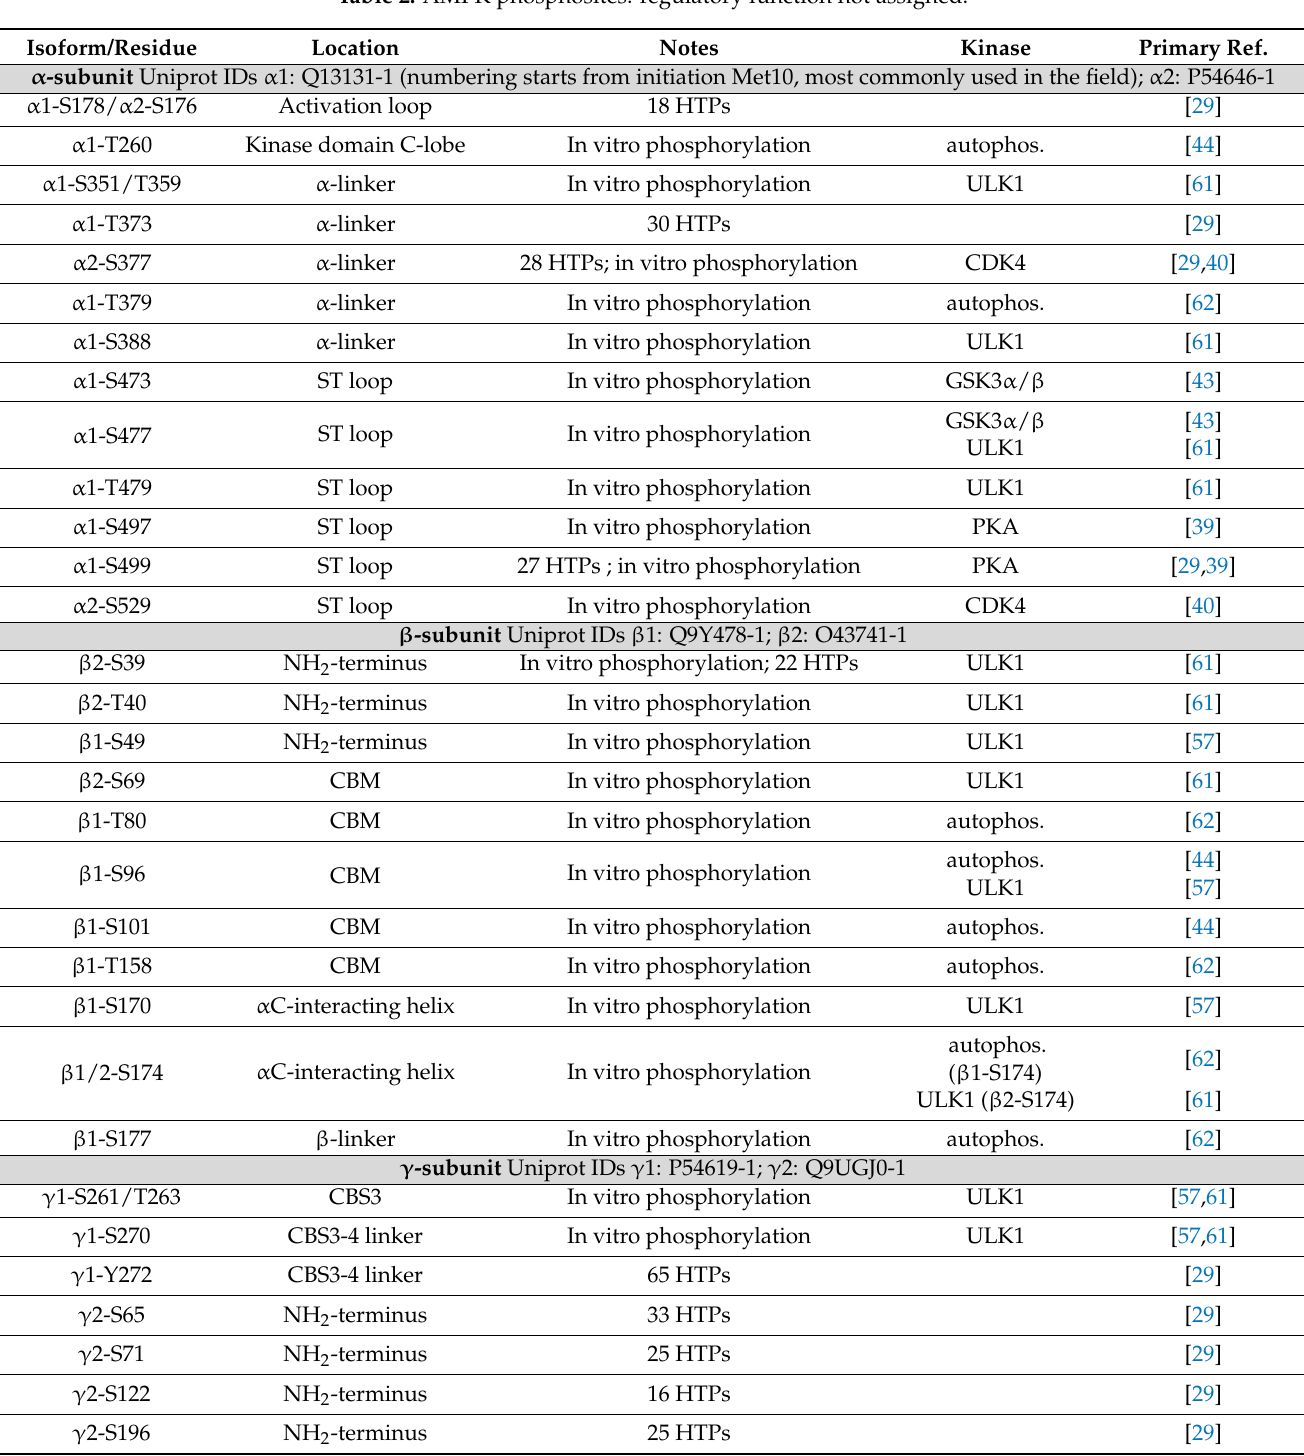
Table 2. AMPK phosphosites: regulatory function not